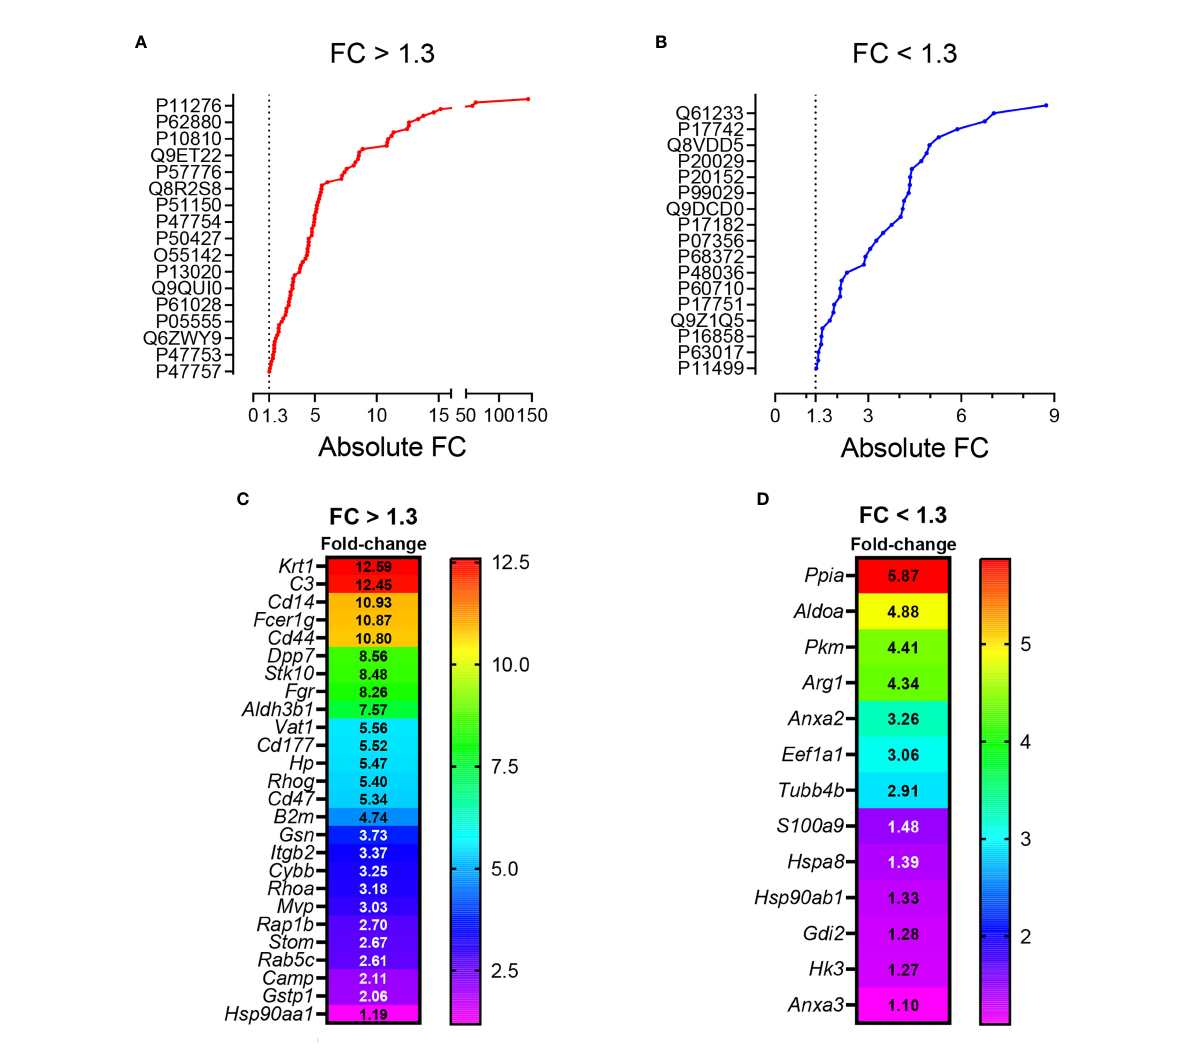
representing the absolute FC values of the neutrophil signature EV proteins with increased abundance relative to Cd38 -/- PECs. (D) Heat map representing the absolute FC values of the neutrophil signature EV proteins with decreased abundance relative to Cd38 -/- PECs. In (C, D) names of the codifying genes are shown (left rows). Neutrophil signature EV proteins with an absolute FC below 1.3 are also